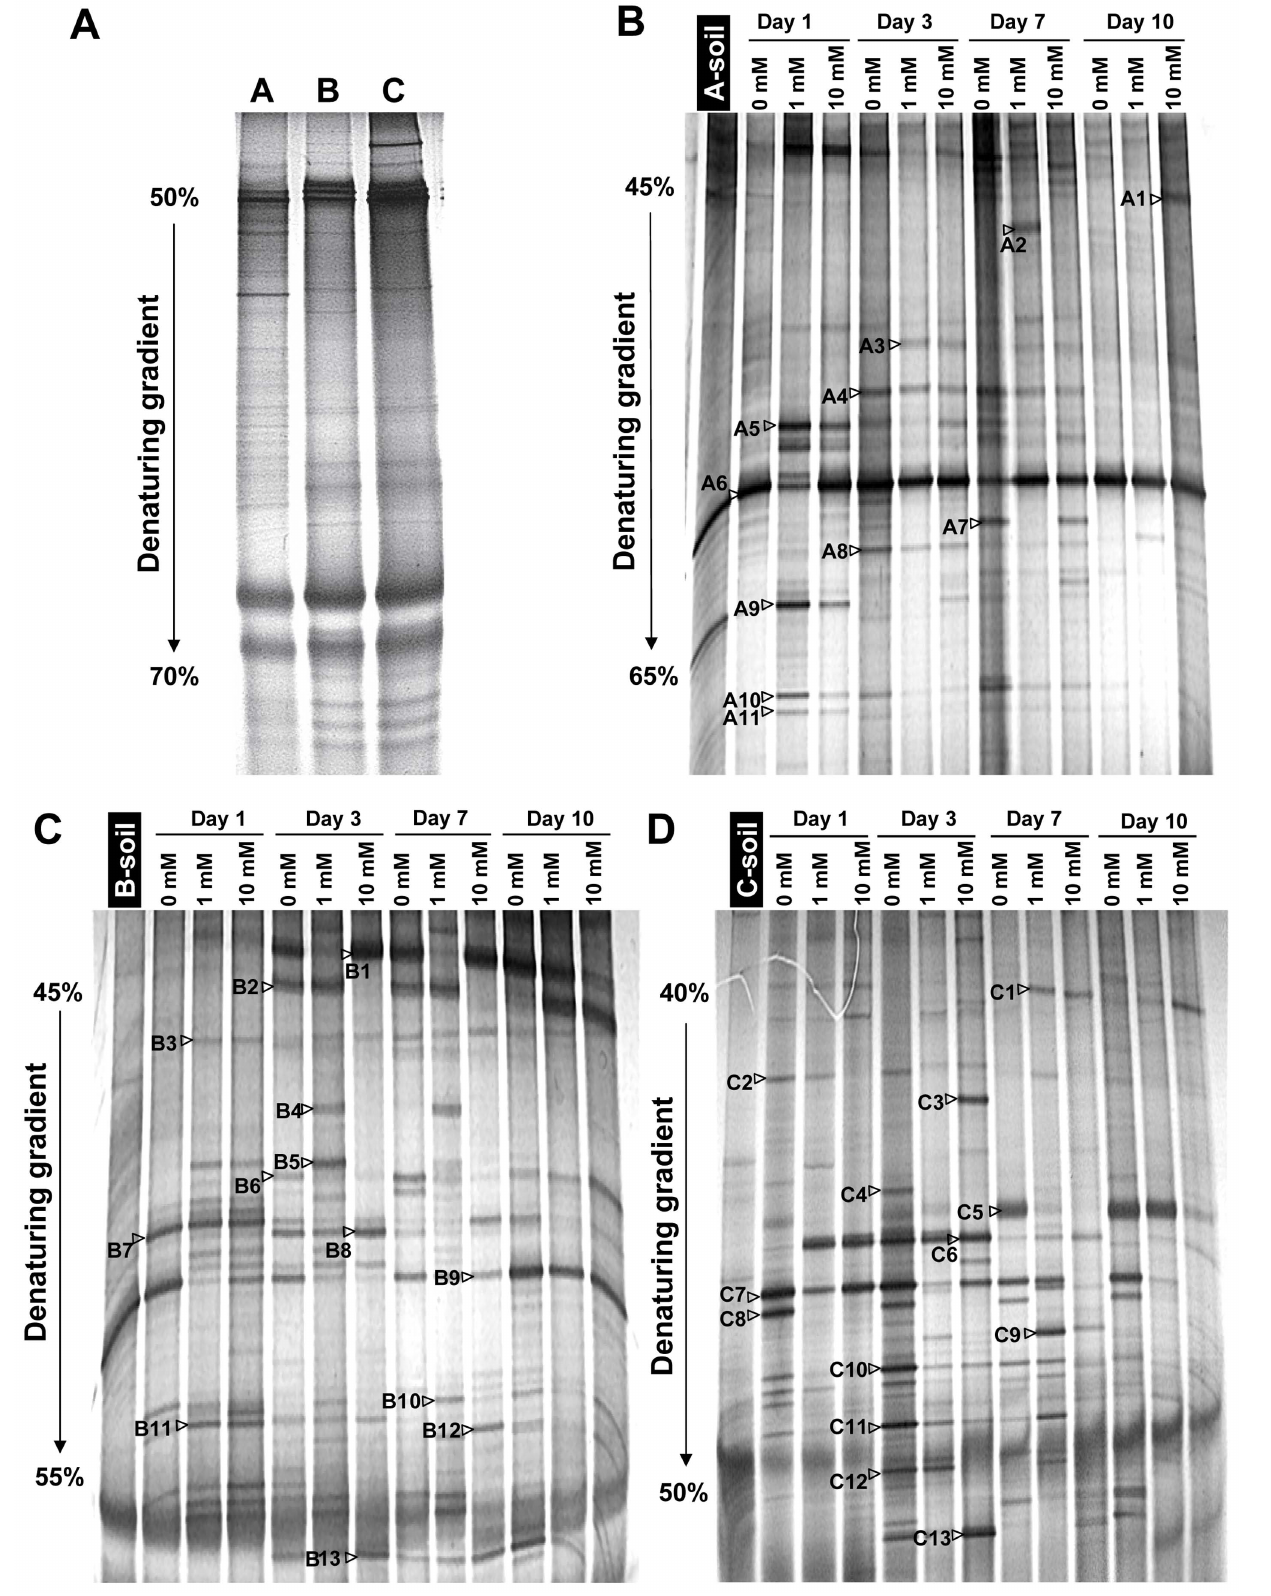
Figure 2. DGGE analysis of bacterial 16S rRNA V3 genes amplified from the total community DNA of the untreated soil (represented by A, B, and C labeled in lanes) and Mn (II)/carbon-rich complex medium-enriched soil (represented by 0, 1, and